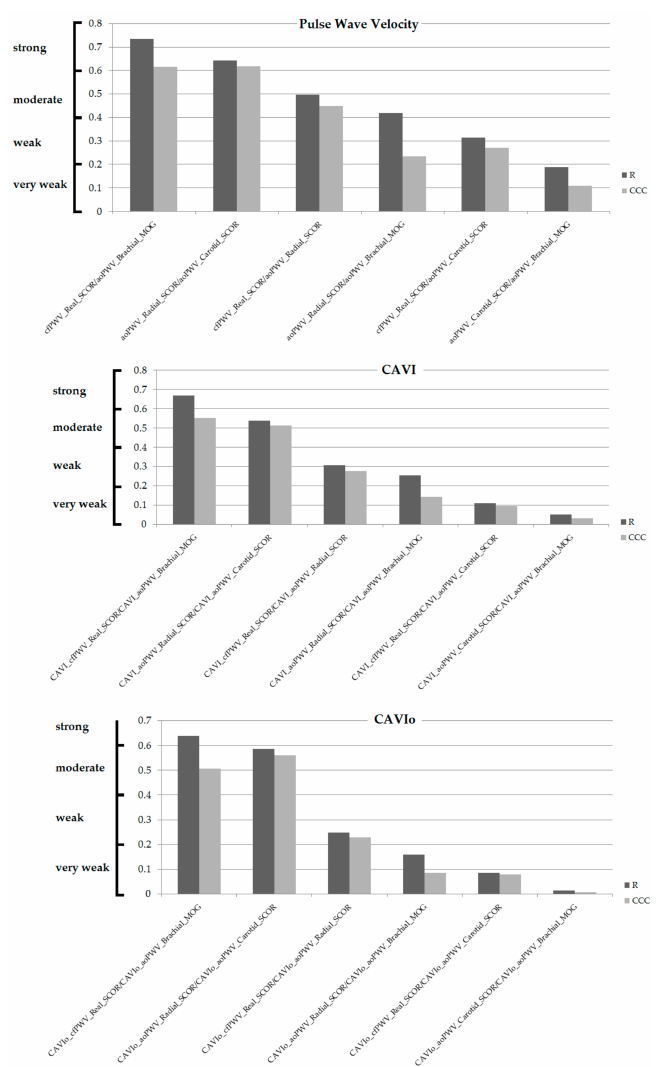
Figure 5. Simple (Pearson, r) and concordance correlation coefficients (CCCs), ordered from highest to lowest based on r value, for PWV ( top ), CAVI ( middle ) and CAVIo ( bottom ). Evans’s Empirical Classifications of Interpreting Correlation Strength by Using r was applied: (i) very weak: <0.20; (ii) weak: 0.20–0.39, (iii) moderate: 0.40–0.59, (iv) strong: 0.60–0.79, (v) very strong: r ≥ 0.80